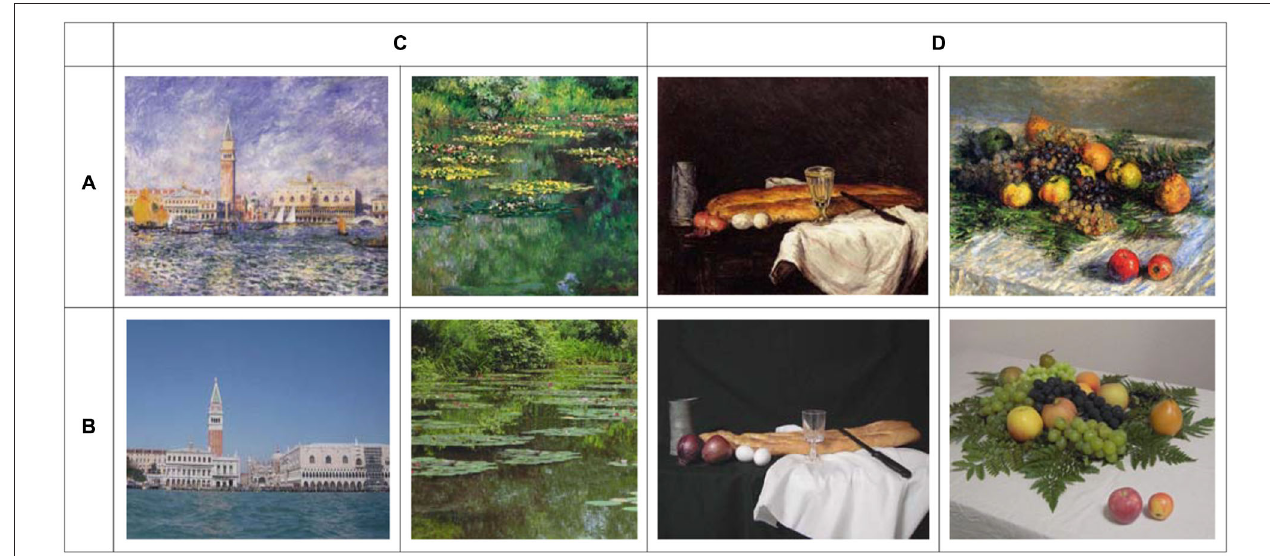
FIGURE 1 | Example of painting and photographic analogs stimuli in this study. (A) Paintings (B) photographic analogs (C) landscape (D) still